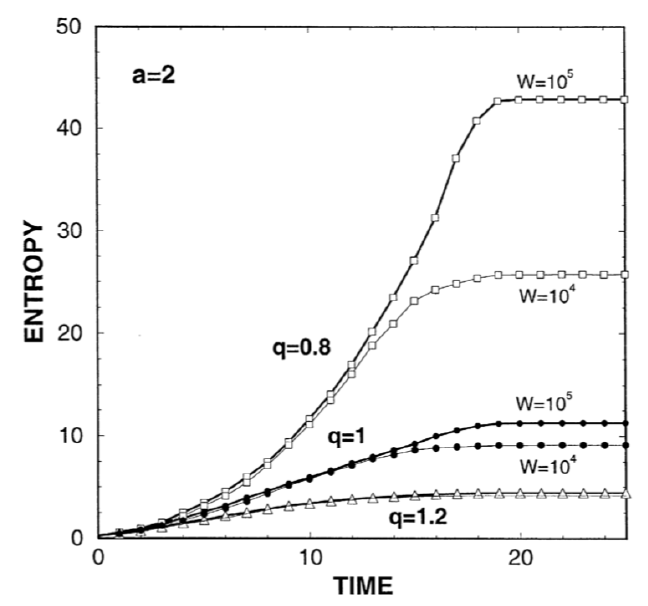
Figure 5. Time evolution of S q for a = 2. The interval [ − 1,1 ] is partitioned into W equal cells. The initial distribution consists of M = 10 6 points placed at random inside a randomly picked cell. We indicate three typical values of q and the two cases W = 10 4 and W = 10 5 . Results are averages over 100 runs. From [95].